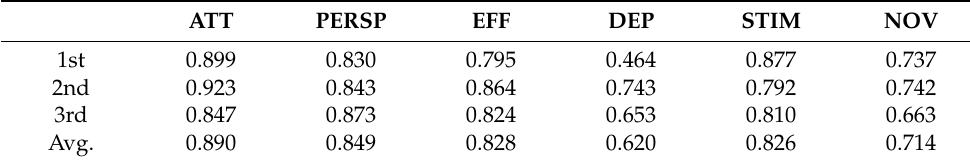
Table 3. Cronbach’s alpha coefficient for UEQ.